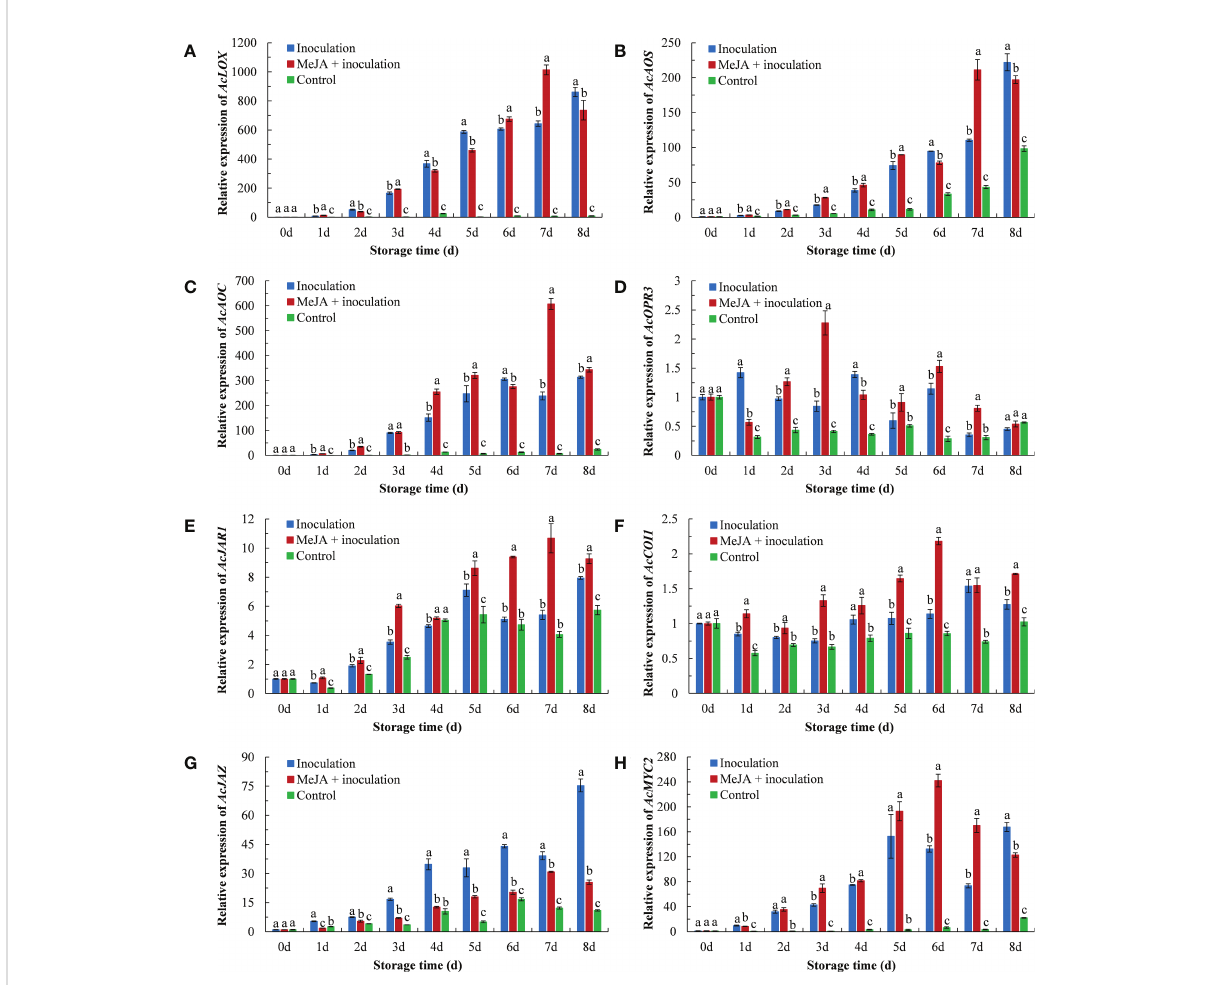
FIGURE 5 MeJA affected the gene expression of (A) AcLOX , (B) AcAOS , (C) AcAOC , (D) AcOPR3 , (E) AcJAR1 , (F) AcCOI1 , (G) AcJAZ , and (H) AcMYC2 in kiwifruit during storage time. Bars shows standard deviation (SD, n=3). Letters indicate signi fi cant differences at P < 0.05 level among the